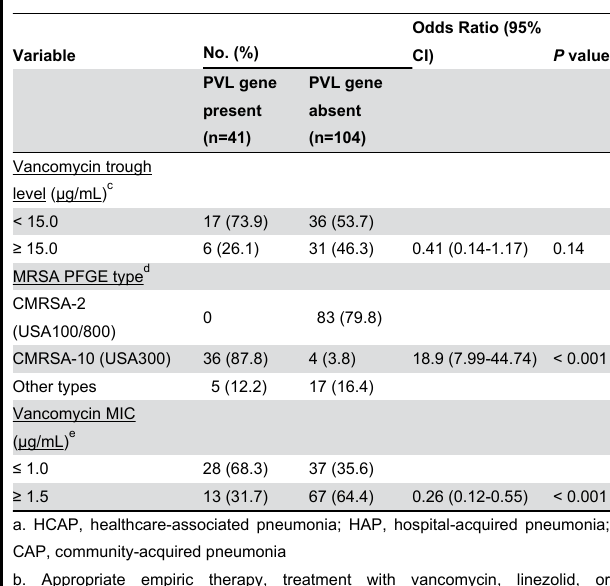
Table 2. Characteristics of patients with methicillin-resistant Staphylococcus aureus (MRSA) pneumonia associated with the presence or absence of the Panton-Valentine Leukocidin (PVL)